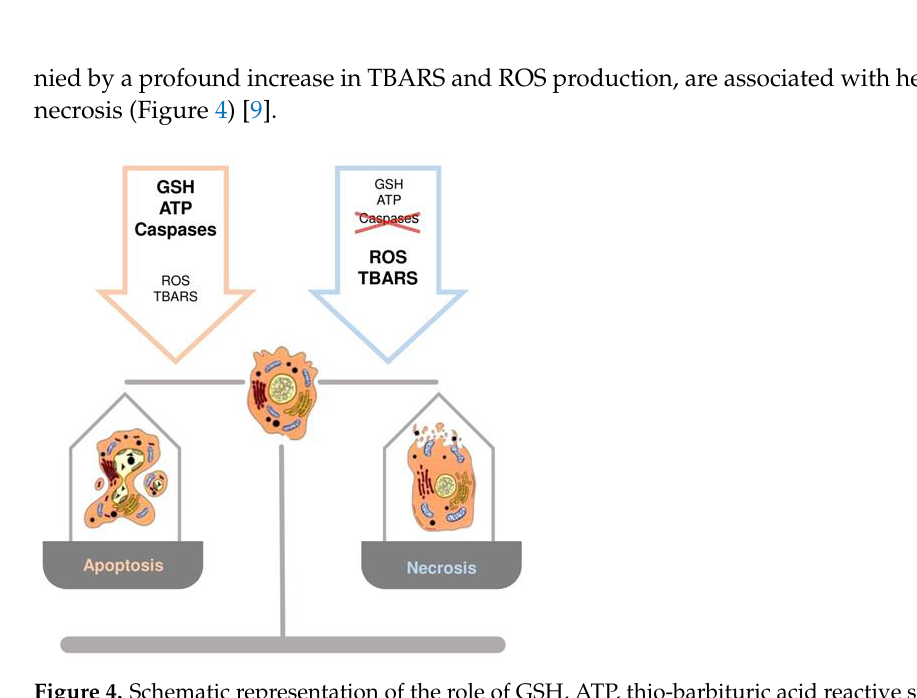
Figure 4. Schematic representation of the role of GSH, ATP, thio-barbituric acid reactive substances (TBARS), reactive oxygen species (ROS) and caspases in the regulation of cell death, apoptosis or necrosis.